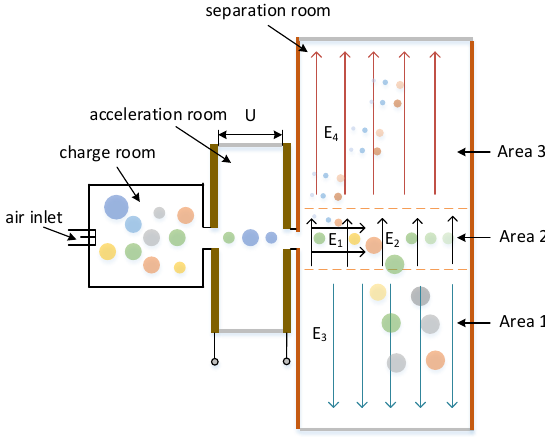
Figure 1. Proposition of composition and principle of atmospheric particulate separation matter based on the compound electric field.